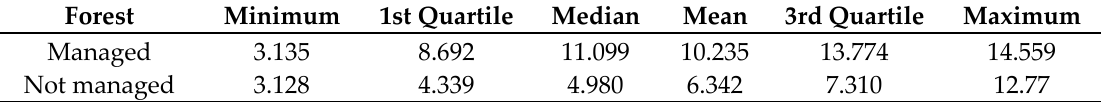
Table 1. Statistics of the growth biomass values (Mg ha − 1 ) for both managed and not managed forests.